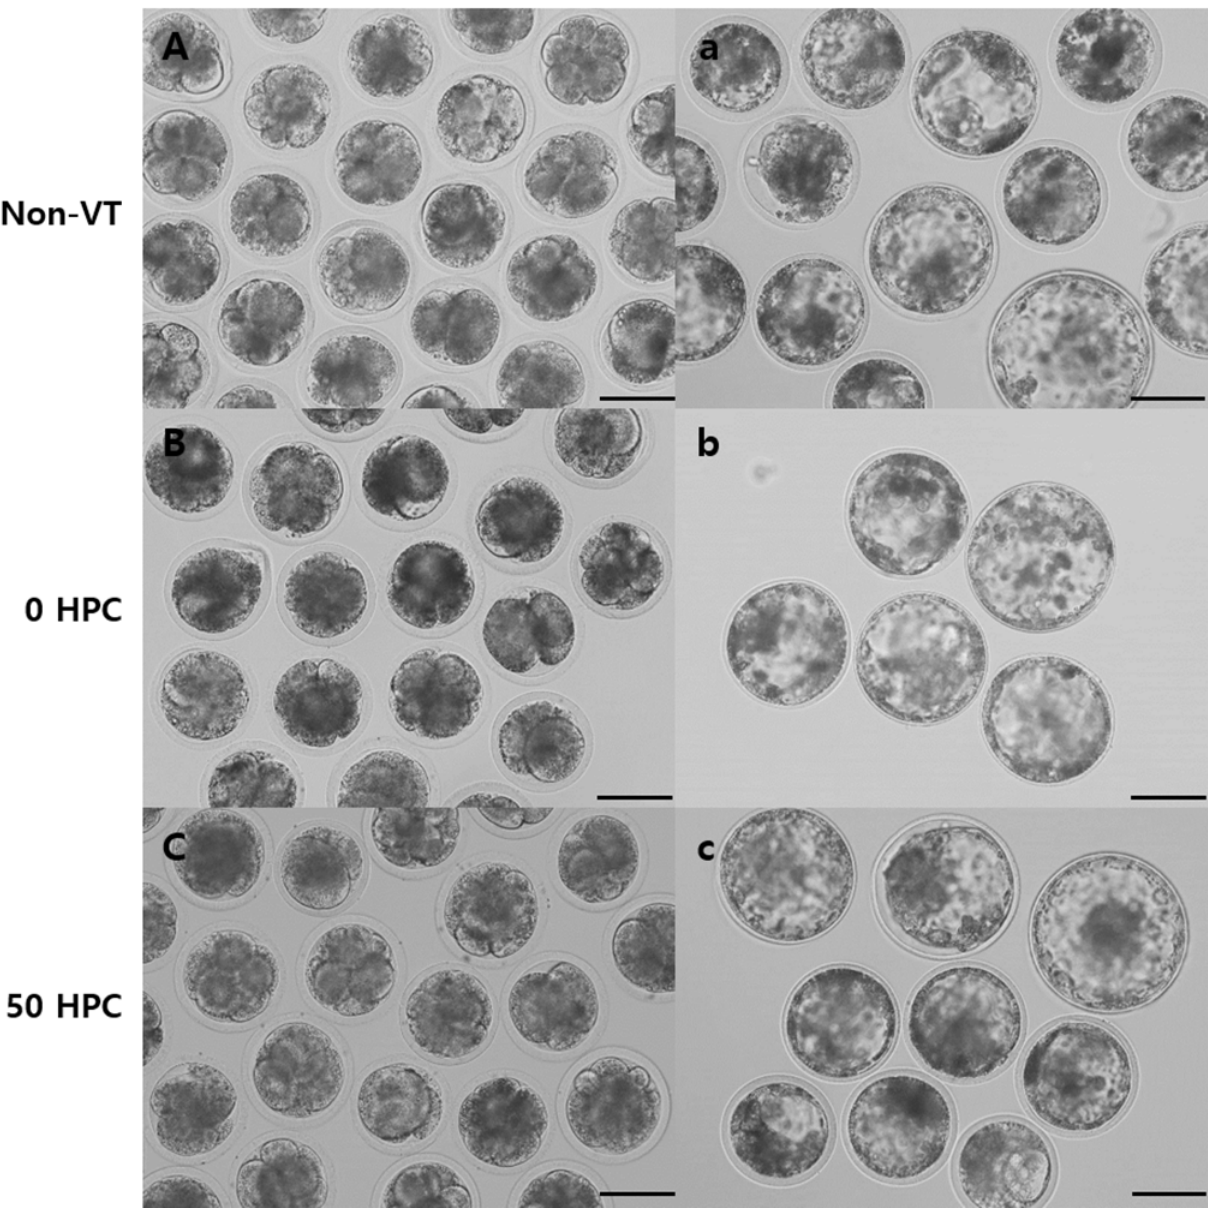
Figure 4. Morphologies of embryos obtained via PA in the non-VT, 0 HPC, and 50 HPC groups. Images of cleaved embryos at day 2 (( A ), non-VT; ( B ), 0 HPC; and ( C ), 50 HPC) and blastocysts at day 8 (( a ), non-VT; ( b ), 0 HPC; and ( c ), 50 HPC). Bar, 100 µm.